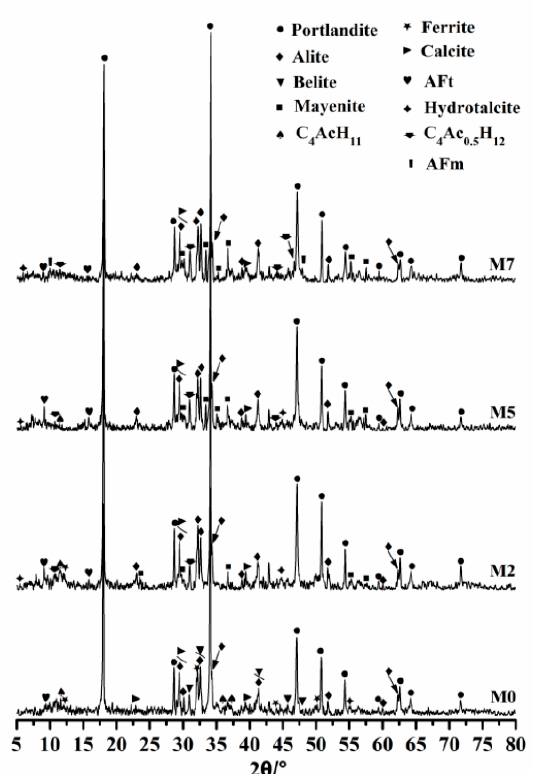
Figure 8. XRD spectra of hydrated products at 3 d age with a w/b = 0.4 at 20 °C.